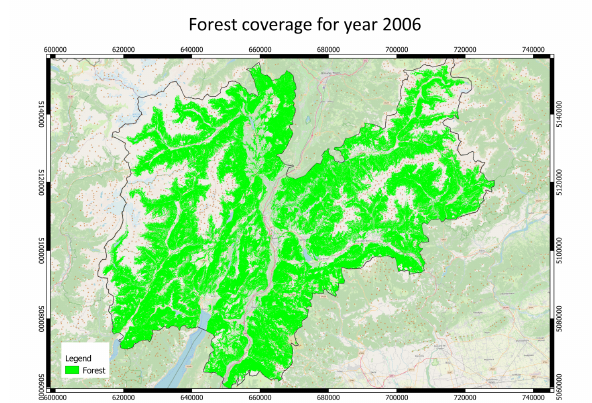
Figure 12. Forest coverage in the Trentino region in 2006.